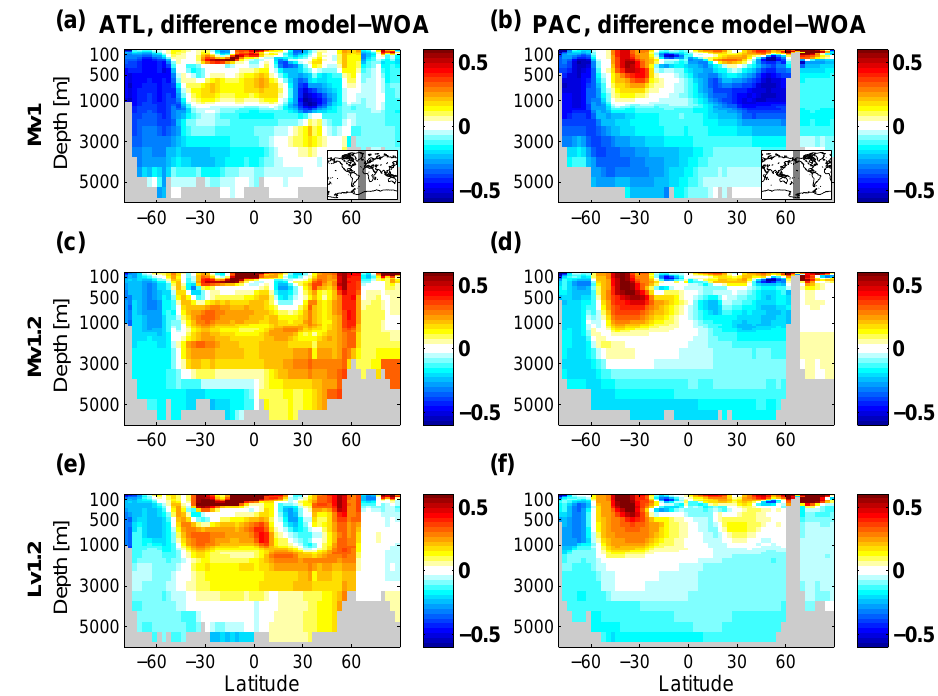
Figure 2. As Fig. 1 but for